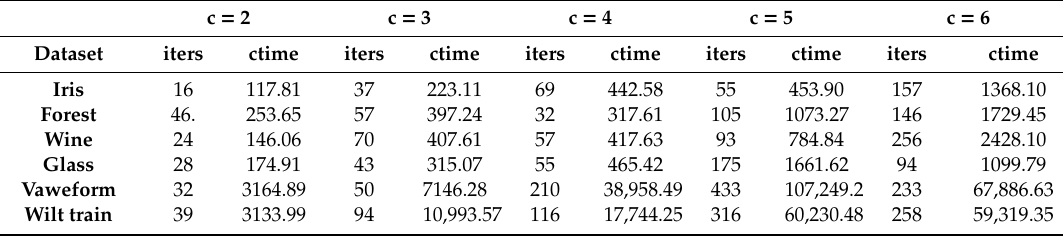
Table 6. Performance of the InoFrep algorithm on the real datasets.